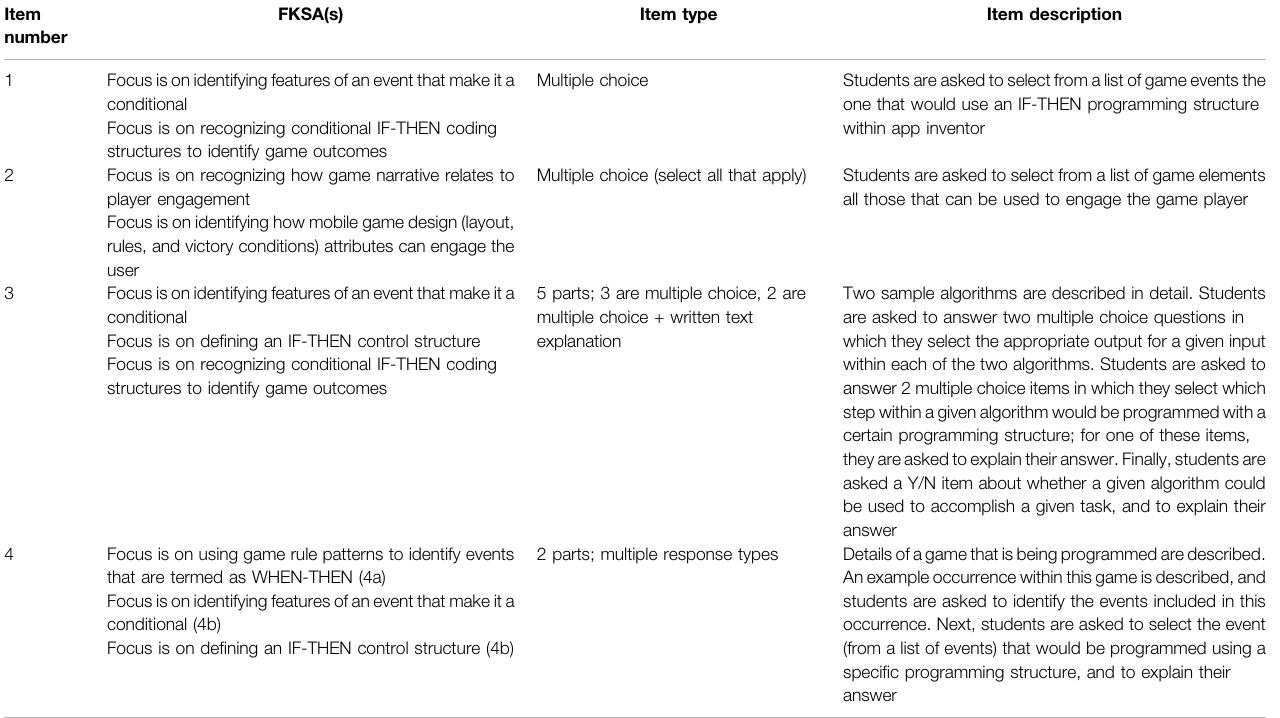
TABLE 5 | Overview of unit 4 assessment items.